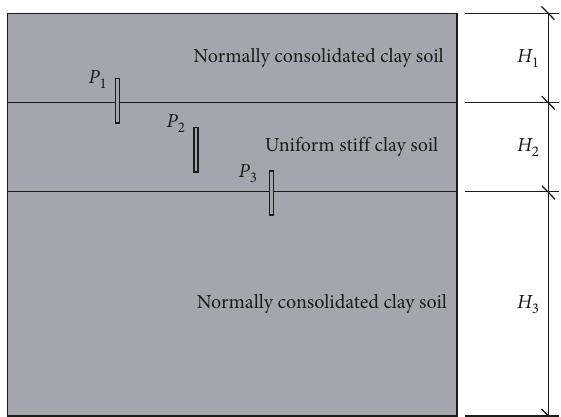
Figure 7: The soil flow around plate anchors in (a) normally consolidated soil ( Z process is completed.